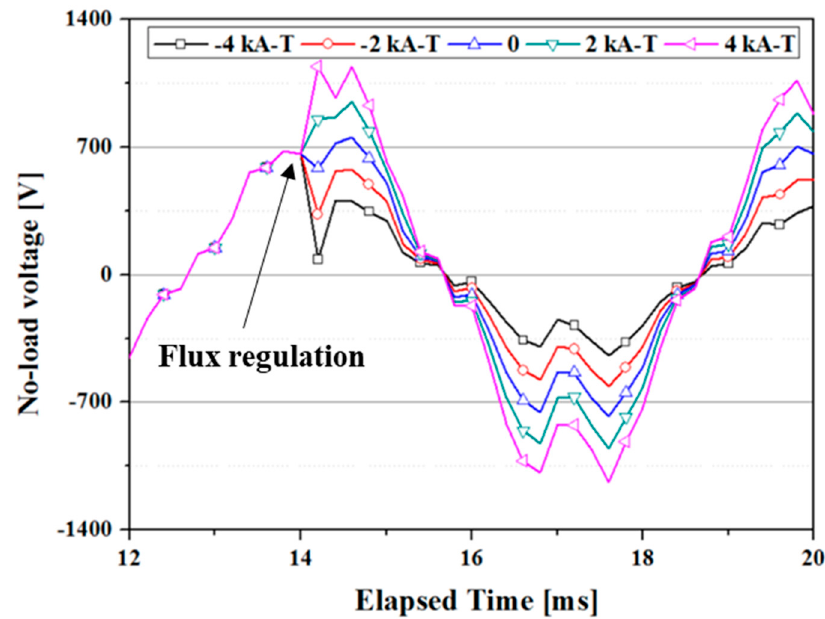
Figure 19. No-load voltage of Phase C according to the MMF of the additional field winding.